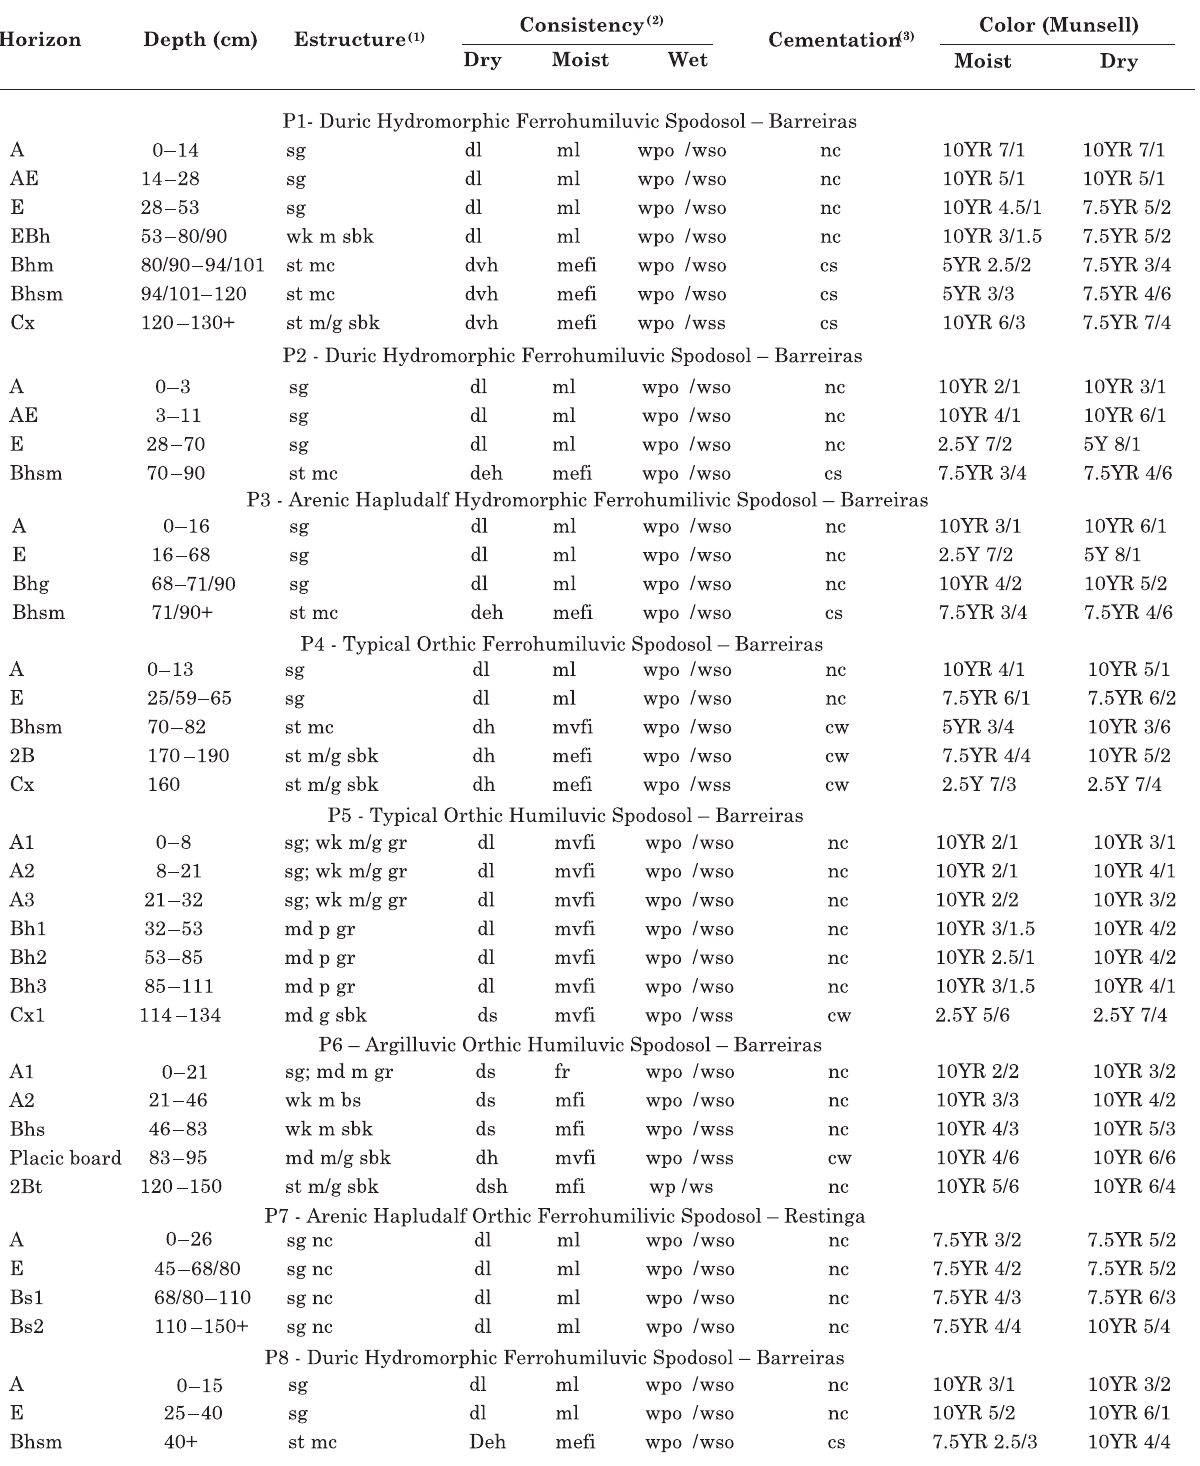
Table 1. Morphological properties of the soil